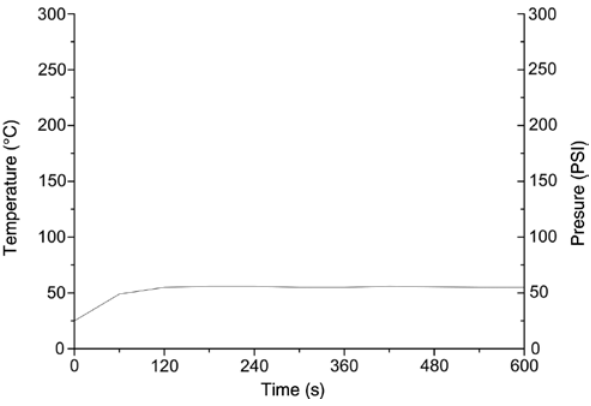
Figure 1: Temperature variation in microwave reactor during